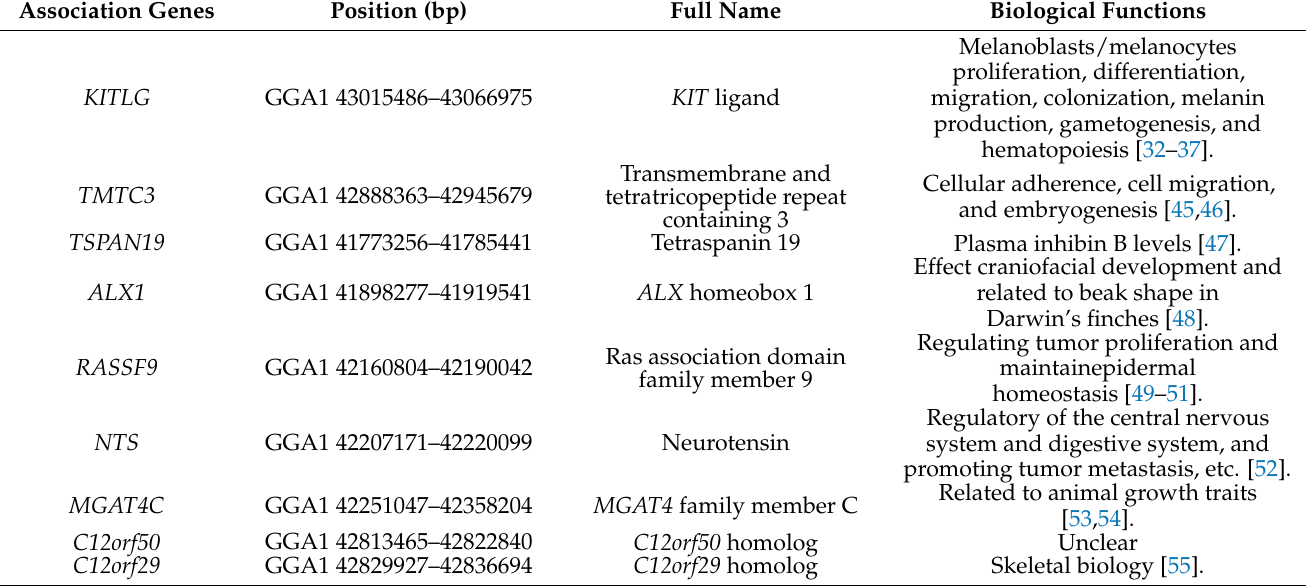
Table 3. Known genes associated with a stripe pattern of RIR chicks in